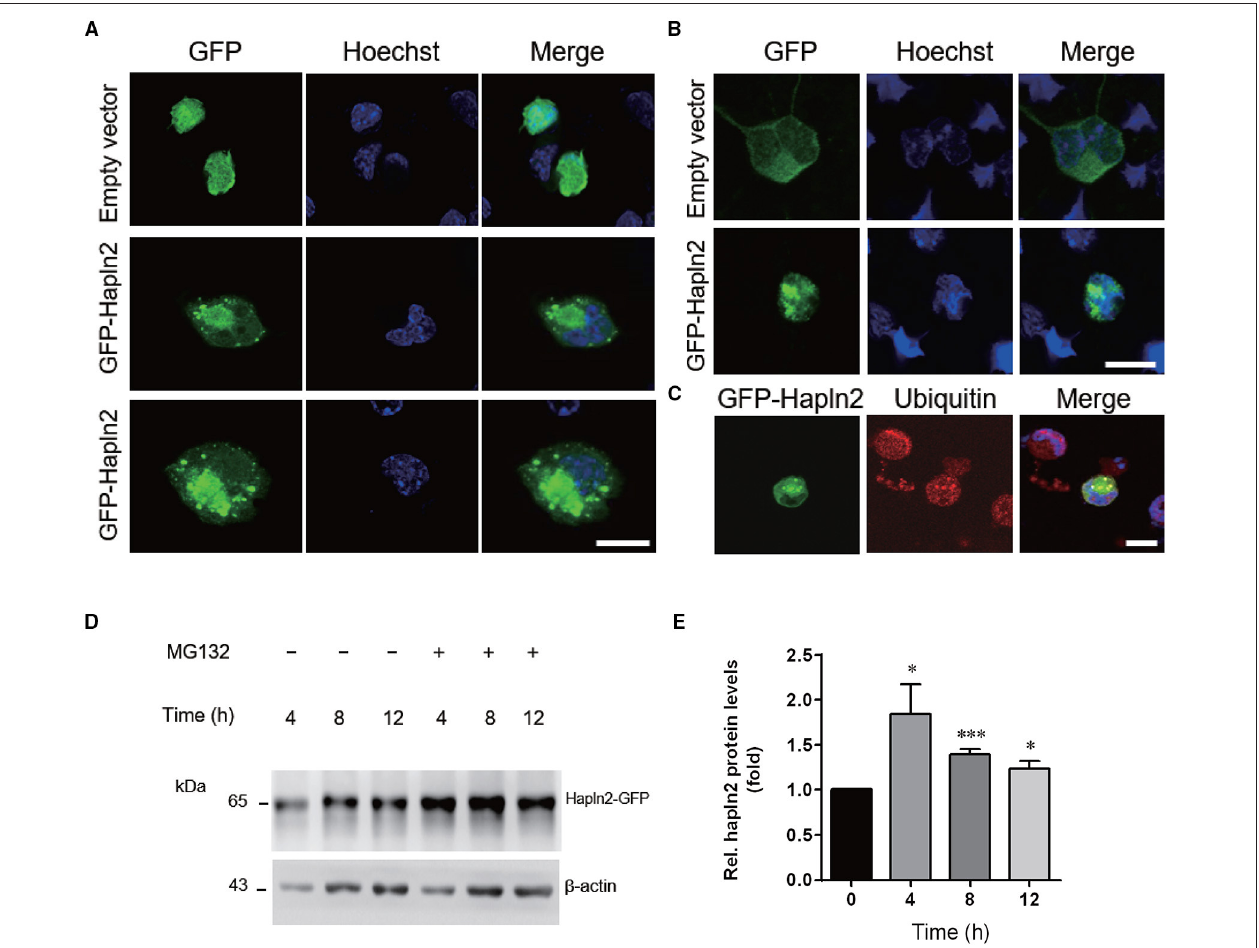
FIGURE 5 | Hapln2 is associated with ubiquitin-proteasome pathway (UPP). (A) Confocal images of Hapln2 aggregates in MES23.5 cells transfected with Hapln2-GFP plasmids. Scale bar = 10 µ m. (B) Representative photomicrographs showing Hapln2 aggregates in primary cortical neurons transfected with GFP- Hapln2 plasmids. Scale bar = 10 µ m. (C) Immunofluorescent staining for ubituitin in MES23.5 cells transfected with Hapln2-GFP plasmids. Scale bar = 10 µ m. (D) Expression levels of Hapln2-GFP was analyzed in MES23.5 cells transfected with the Hapln2-GFP plasmid at indicated times after MG132 (20 µ M) treatment.